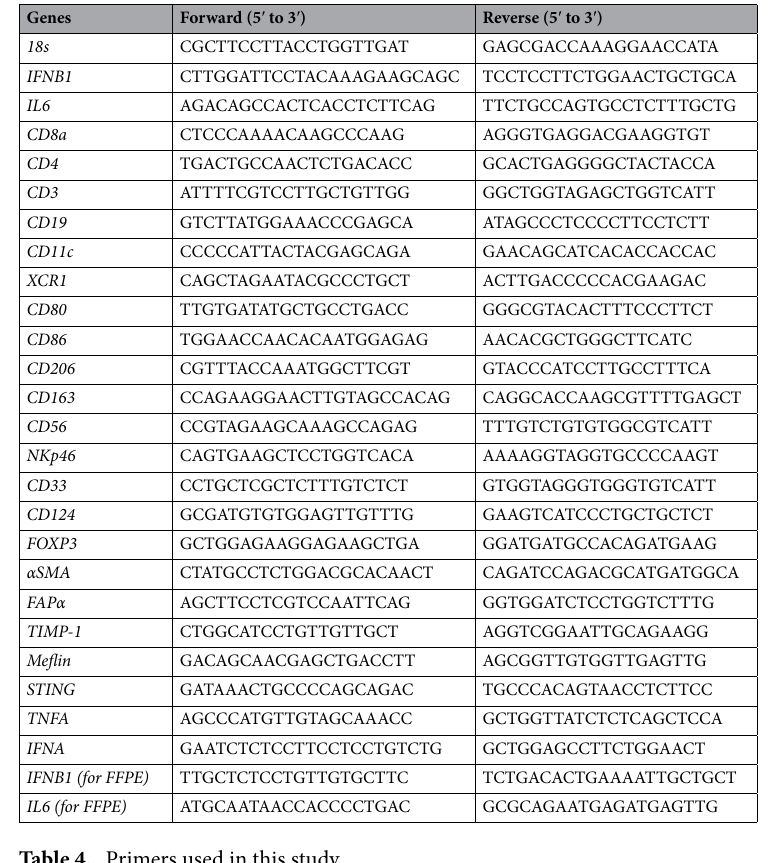
Table 4. Primers used in this